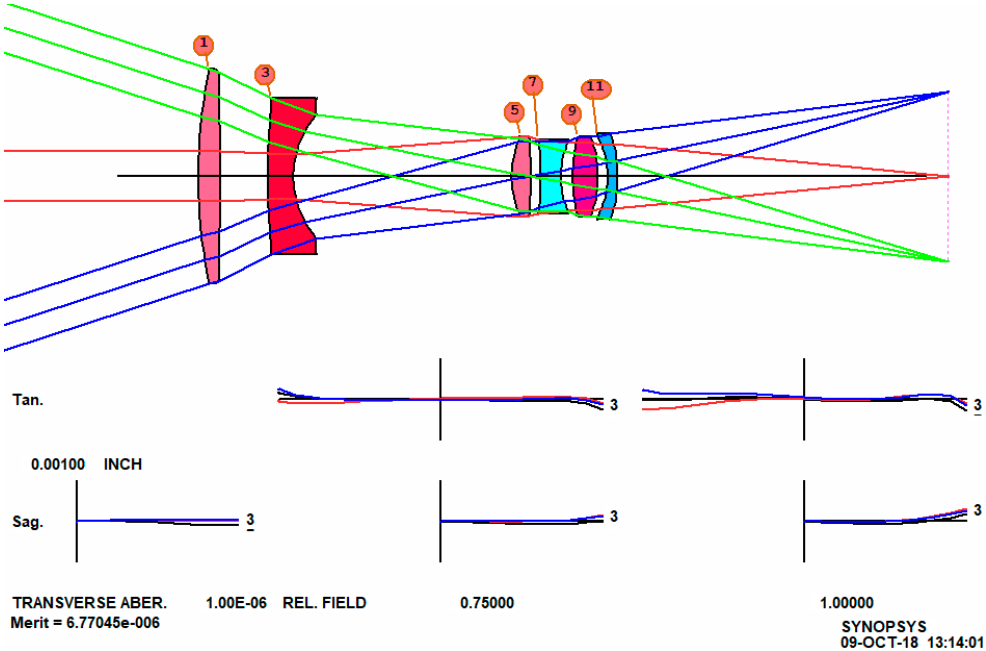
Figure 9. Saddle-point build (SPBUILD) solution to the inverse telephoto problem.